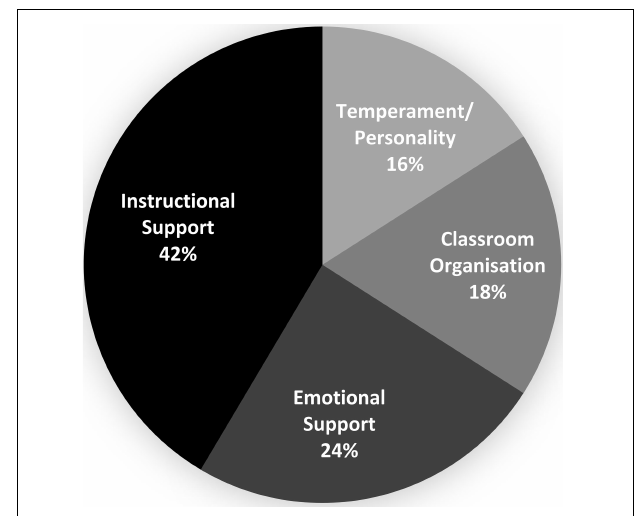
FIGURE 1 | Distribution of students’ responses coded into four